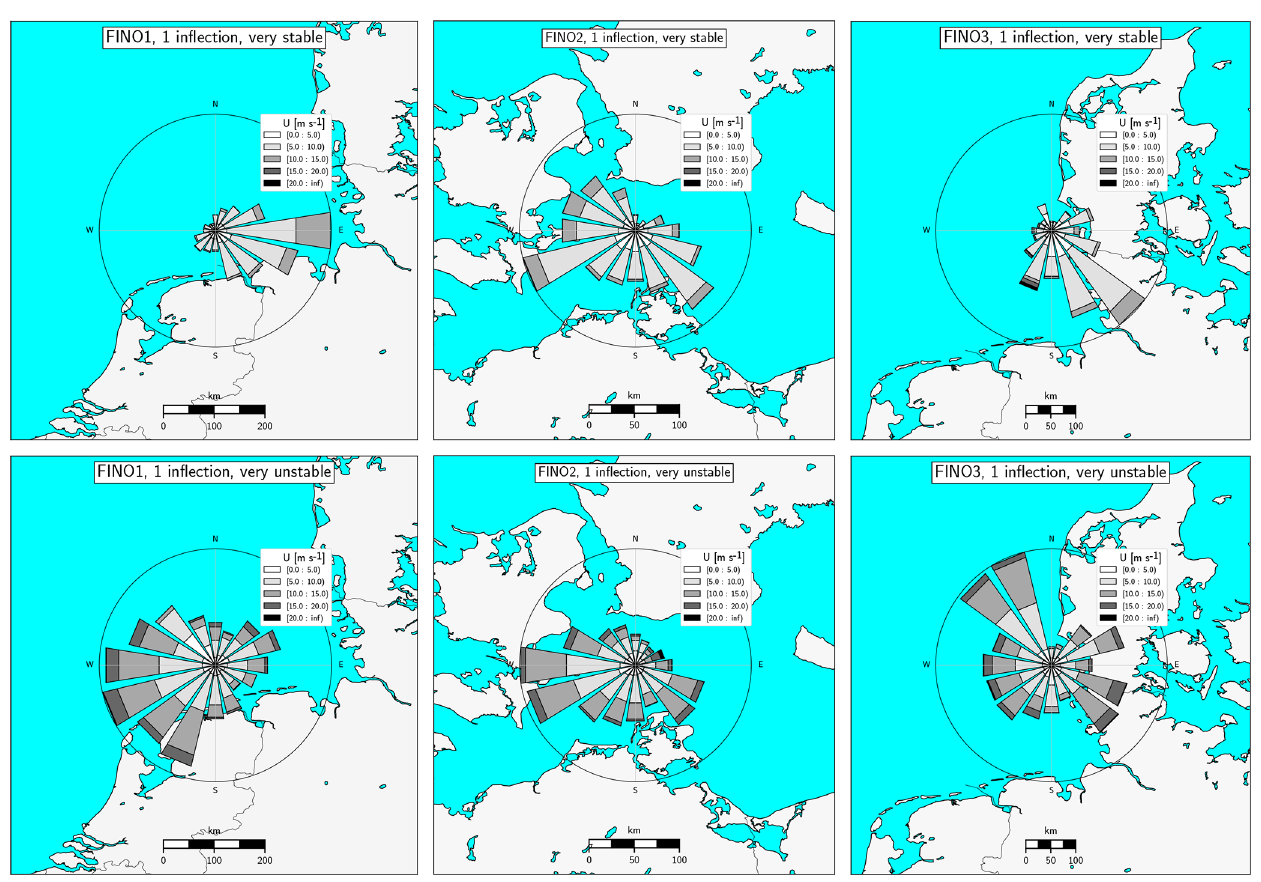
Figure 13. Wind direction of very stable and very unstable 1-inflection profiles at offshore sites. The wind roses are centered on the site